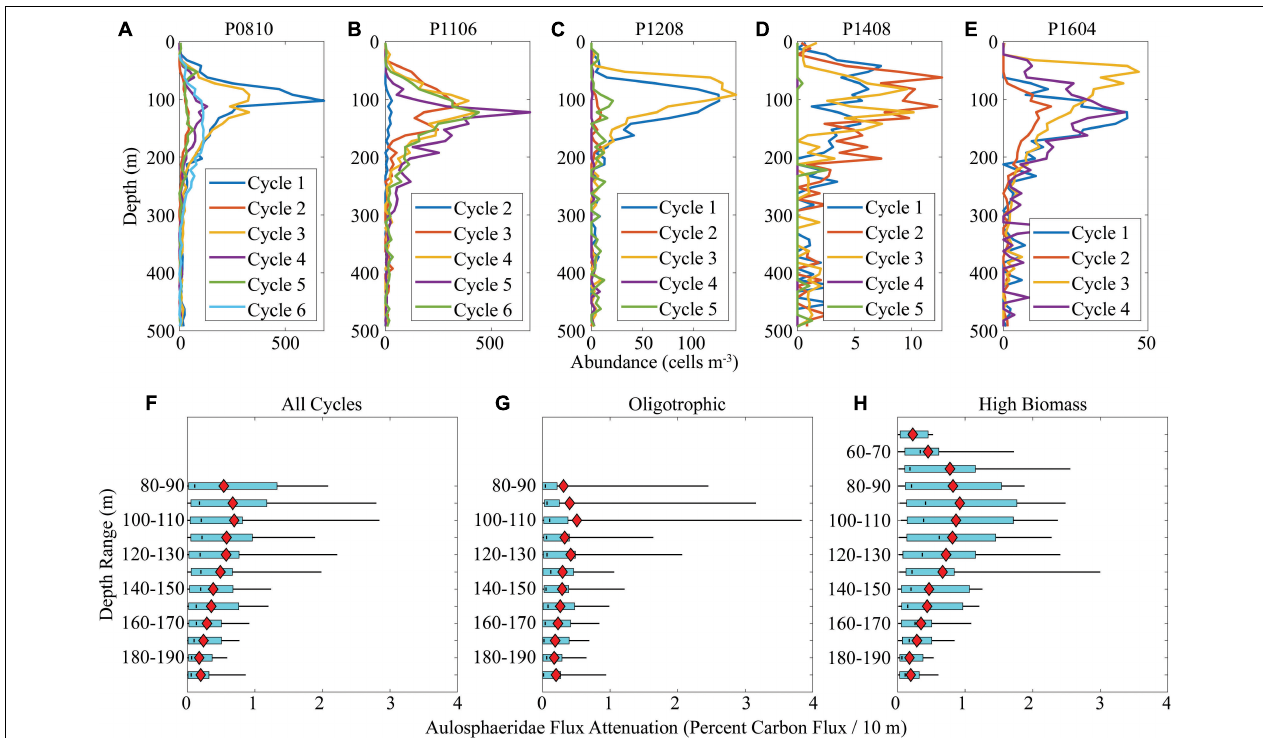
FIGURE 8 | Abundance (A–E) and flux attenuation (F–H) of Aulosphaeridae. Note the different x -axis scales used in panels (A–E) that were necessary because of high inter-cruise variability in Aulosphaeridae abundance. Panels (F–H) show computed flux attenuation mediated by Aulosphaeridae. Light blue boxes show quartiles (median is black line) and thin black lines show 95% confidence intervals (computed using MATLAB function quantile). Red diamonds are arithmetic mean